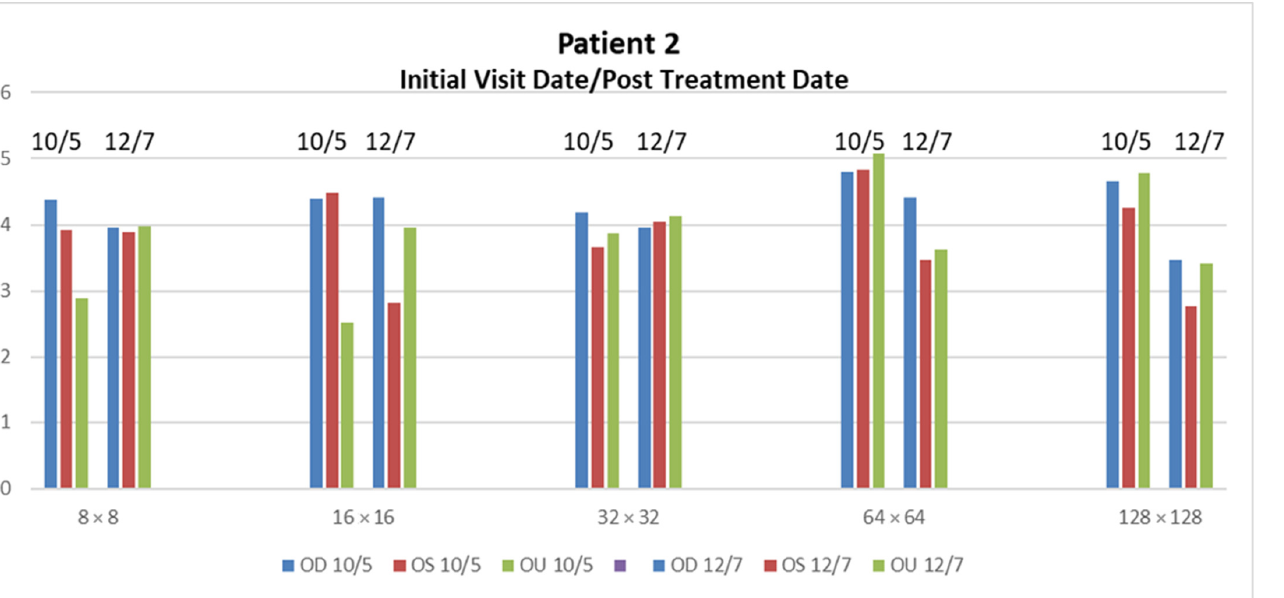
Figure 5. PSD reduction after two months in Patient 6 is seen 8 × 8 and 16 × 16 OU. The restoration of PSD values for these specific areas within the 2–3 range have shown to contribute to the meas- urement of improvement of visual issues from mTBI.